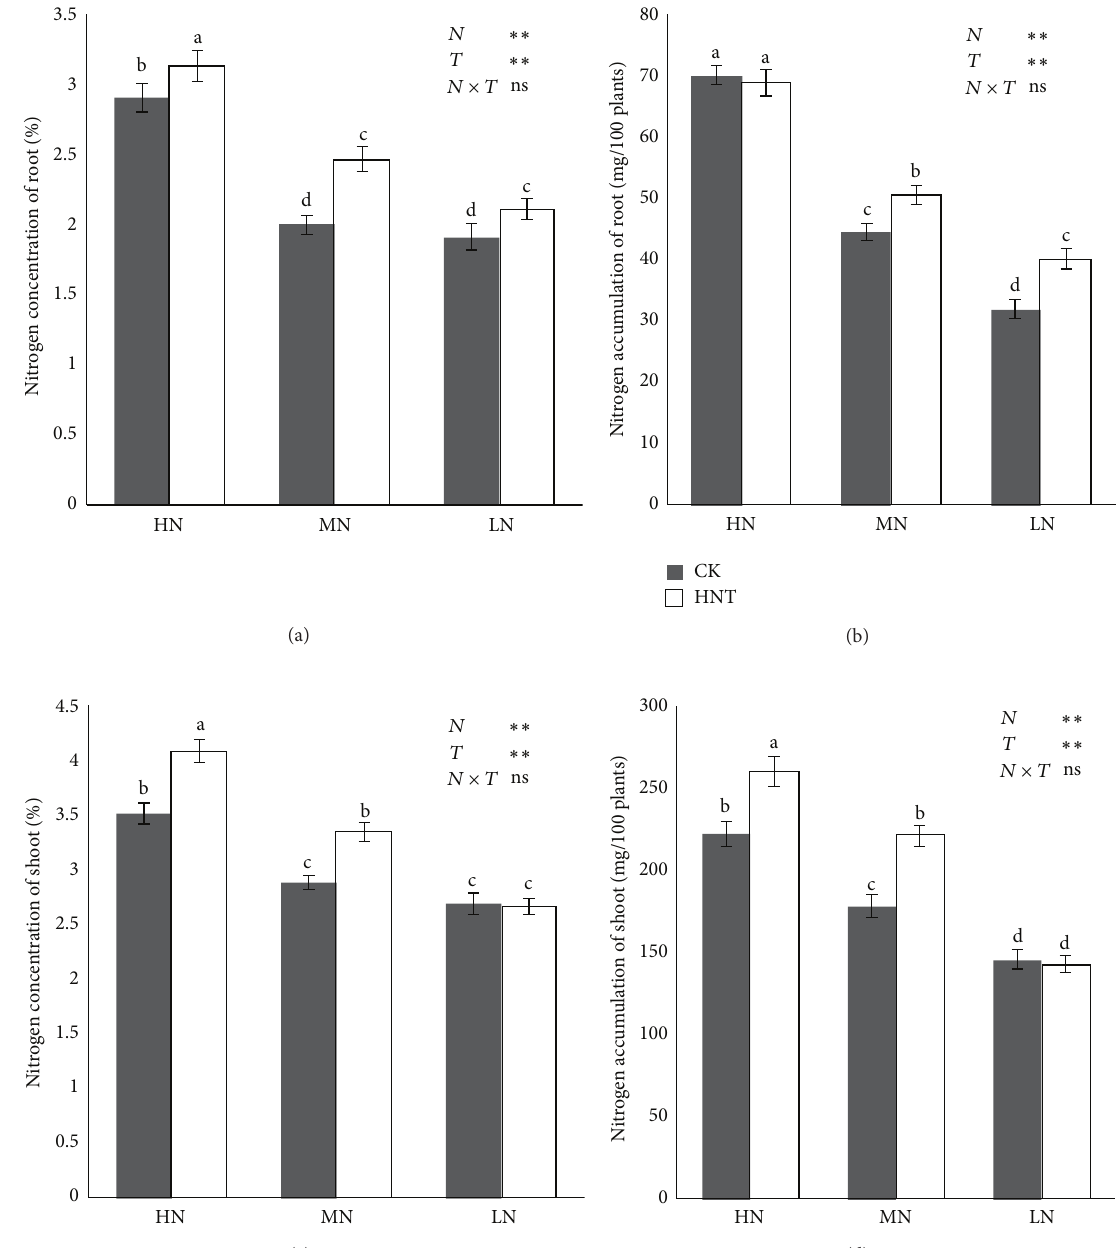
Figure 2: Nitrogen concentration and accumulation in the root and shoot of rice seedling ((a)–(d)). Plants were grown under two temperatures of 22 ∘ C (CK) and 27 ∘ C (HNT) with three nitrogen levels of 10mgN/L (low nitrogen level: LN), 40 mgN/L (moderate nitrogen level: MN), and 160mgN/L (high nitrogen level: HN). Range bars indicate the standard deviation ( 𝑛 = 3 ). ANOVA results are embedded in the figure: ns: not significant; ∗∗ 𝑃 < 0.01 . Columns with the same letter are not significantly different at 𝑃 < 0.05 by Tukey’s HSD.